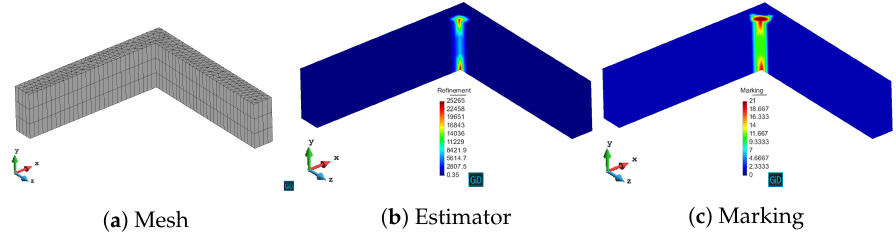
Figure 18. First iteration for L-shaped problem with h adaptivity.